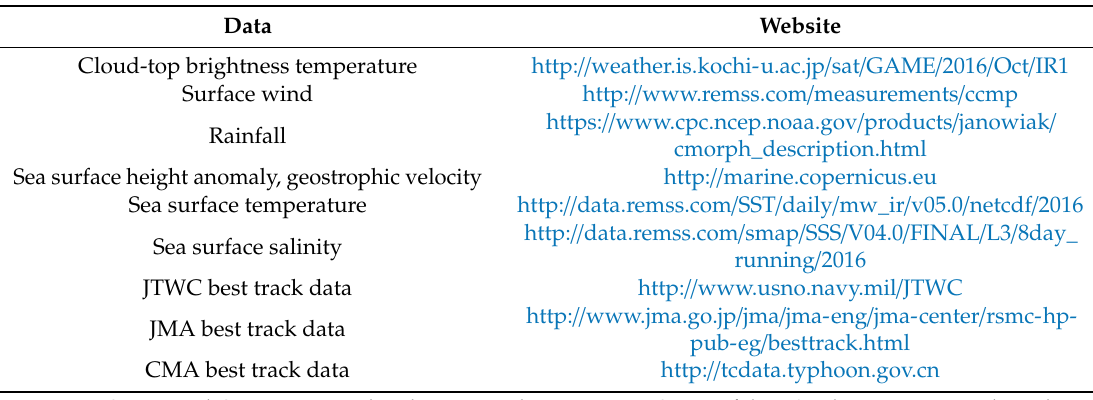
Table 1. Sources of Data